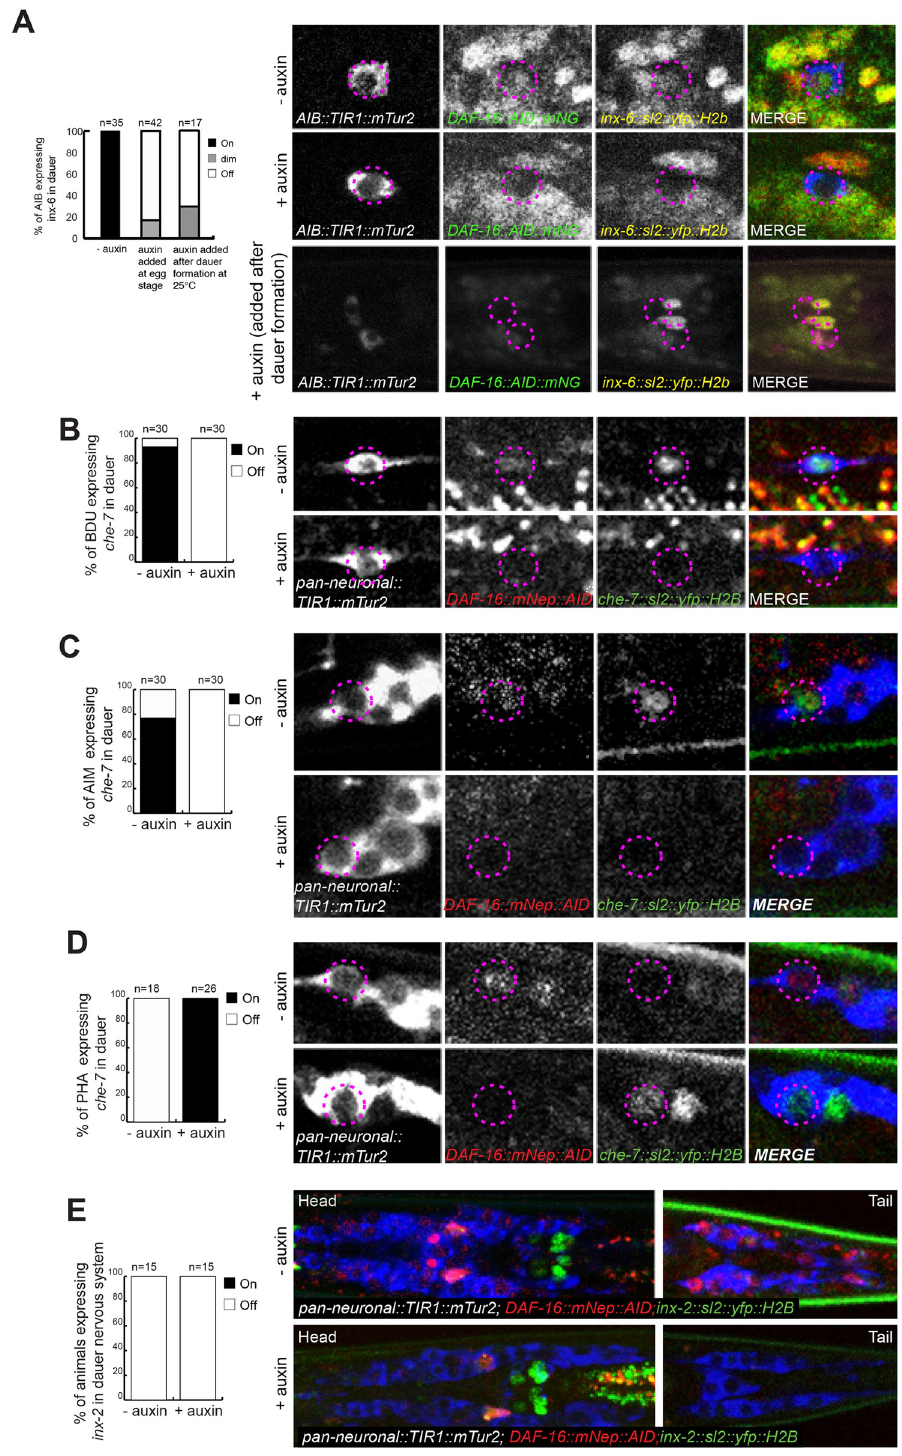
Fig 6. Neuronal removal of DAF-16/FoxO controls dauer-specific expression changes of electrical synapse components. ( A ) The dauer-specific expression gain of an inx-6 reporter allele (ot804) in AIB is affected upon continuous AIB-specific depletion of DAF-16/FoxO, as well as in animals where DAF-16/FoxO is depleted in AIB after dauer remodeling. (B) A che-7 reporter ( otEx7112) expression is gained in BDU neurons in dauer. This dauer-specific che-7 expression is lost upon panneuronal depletion of DAF-16/FoxO in auxin-treated dauers. (C) A che-7 reporter